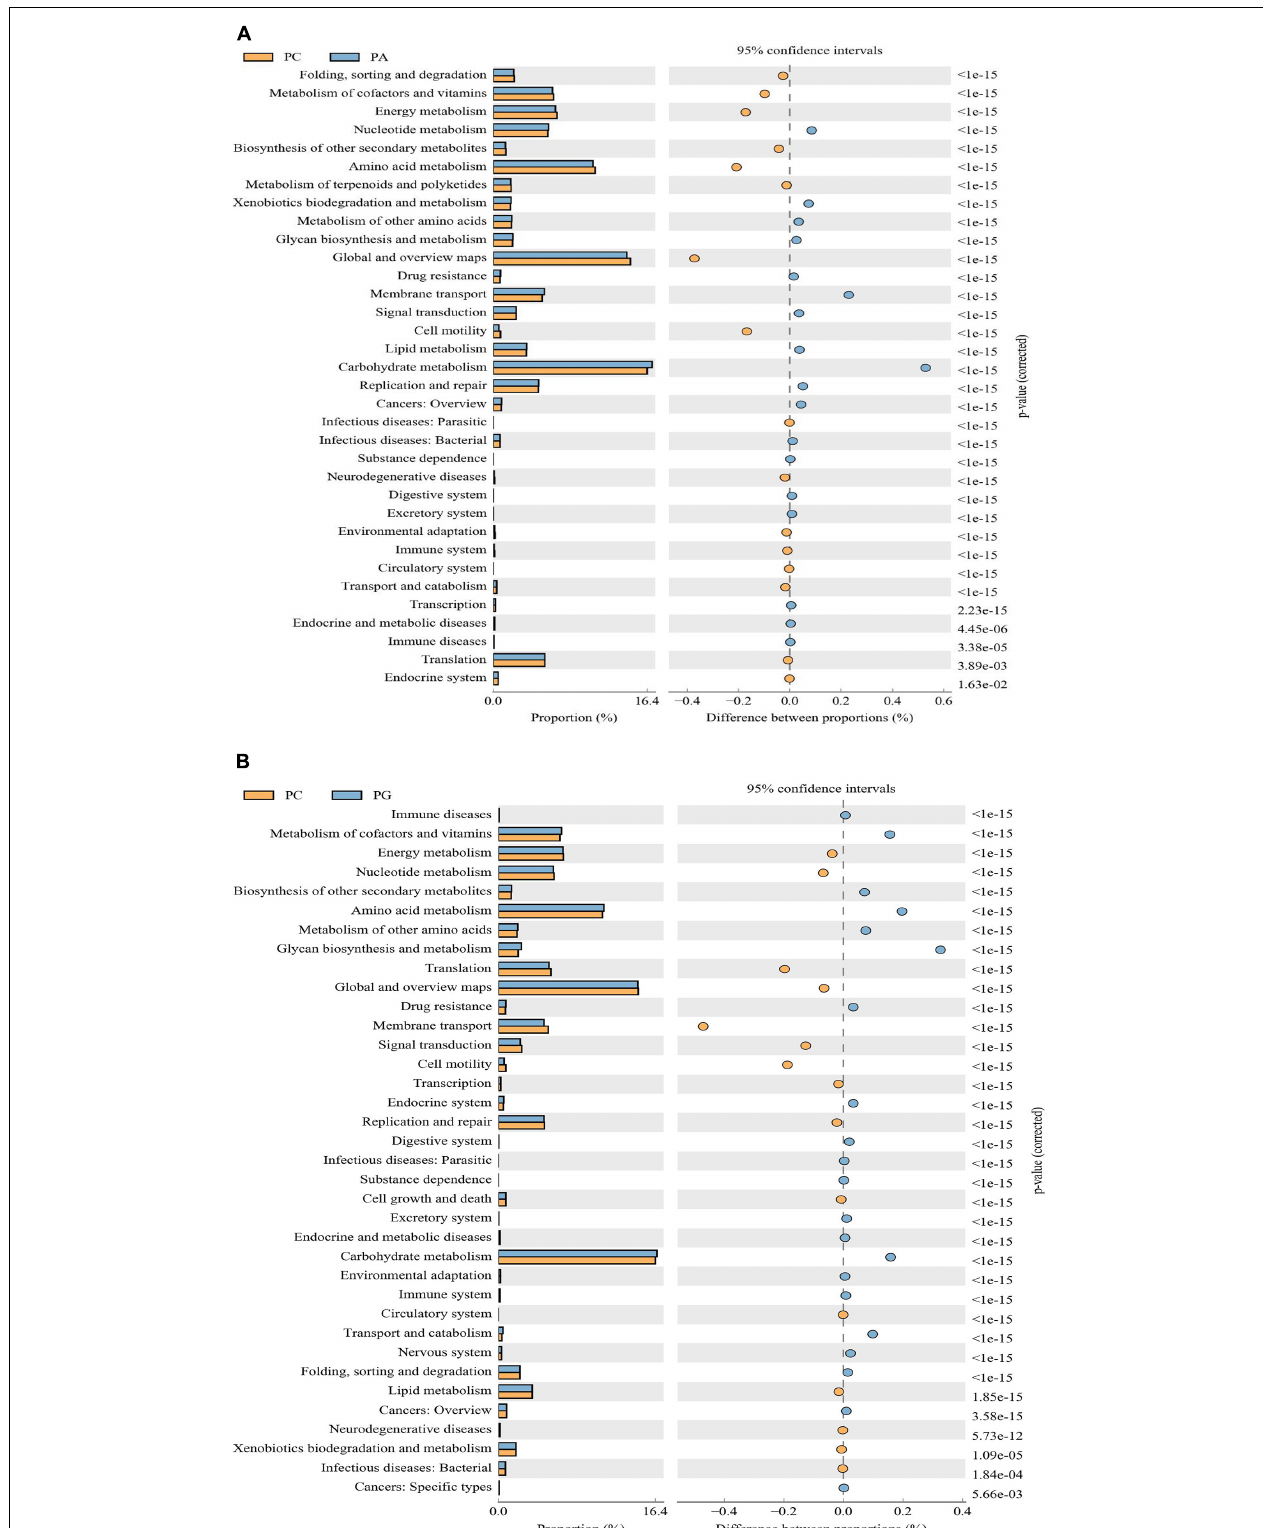
FIGURE 3 | The microbial pathways grouped into level-2 functional categories using PICRUSt. PC between groups PC and PA (A) , and groups PC and PG (B) . PC, basal diet + SNE; PA, basal diet extra antibiotics + SNE; PG, basal diet extra B. licheniformis + SNE.